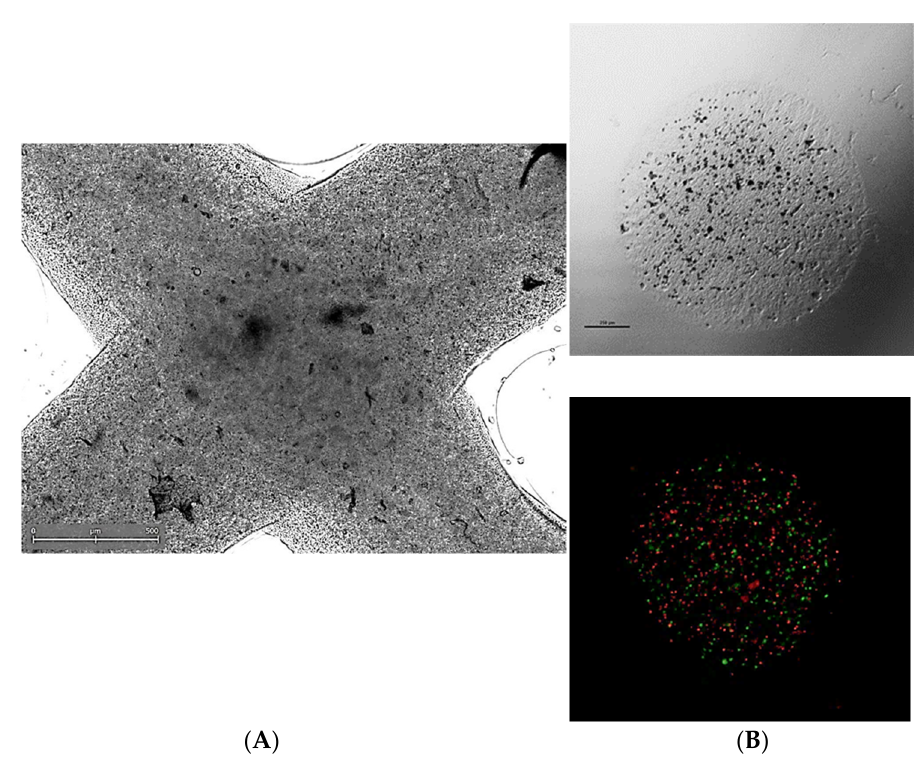
Figure 3. Representative micrographs of 3D-bioprinted co-culture cancer models involving ( A ) extrusion-based method (visible light microscopy) or ( B ) a droplet-based technique in visible light microscopy (upper panel) or fluorescent microscopy (bottom panel)—a mix of PKH67-labeled MSC (green signal) and PKH26-labeled HCT116 colon cancer cells (red signal) was suspended in bioink and co-bioprinted using a BioX bioprinter (CELLINK, Sweden). Courtesy of Ms. Anna S ł ysz (Maria Sklodowska-Curie National Institute of Oncology, Warsaw, Poland).